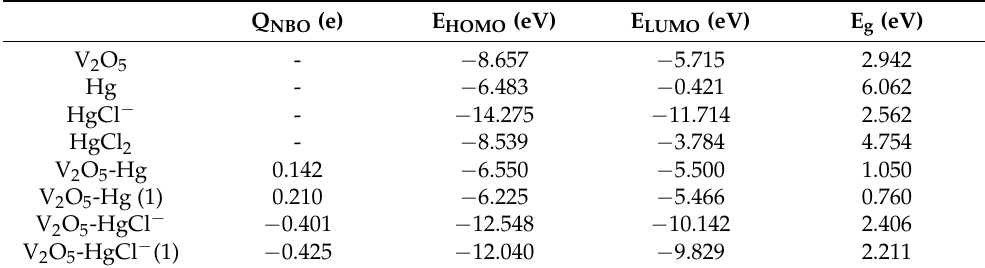
Figure 8. Changes in HOMO and LUMO during Hg 0 oxidation. Table 4. Calculation results of NBO charge transfer, HOMO), LUMO and frontier orbital during Hg 0 oxidation.